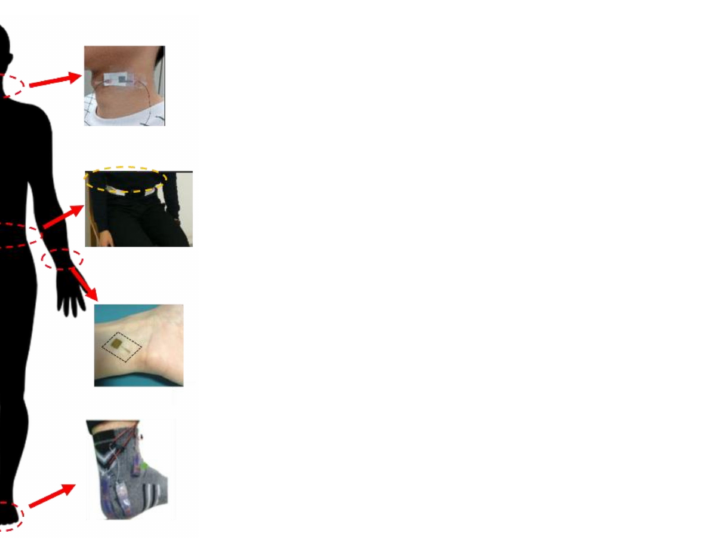
Figure 1. The detection positions for wearable pressure monitoring, such as ears [6], neck [10], arms [13], waist [14], wrists [15,19], fingers [16], chest [17], and feet